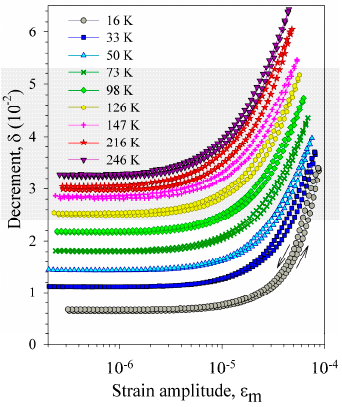
Figure 6. Strain amplitude dependence of the decrement of a Ni 50.8 Ti 49.2 sample, subjected to vacuum annealing No. 4 (VA4), measured at different temperatures during heating from 16 K.